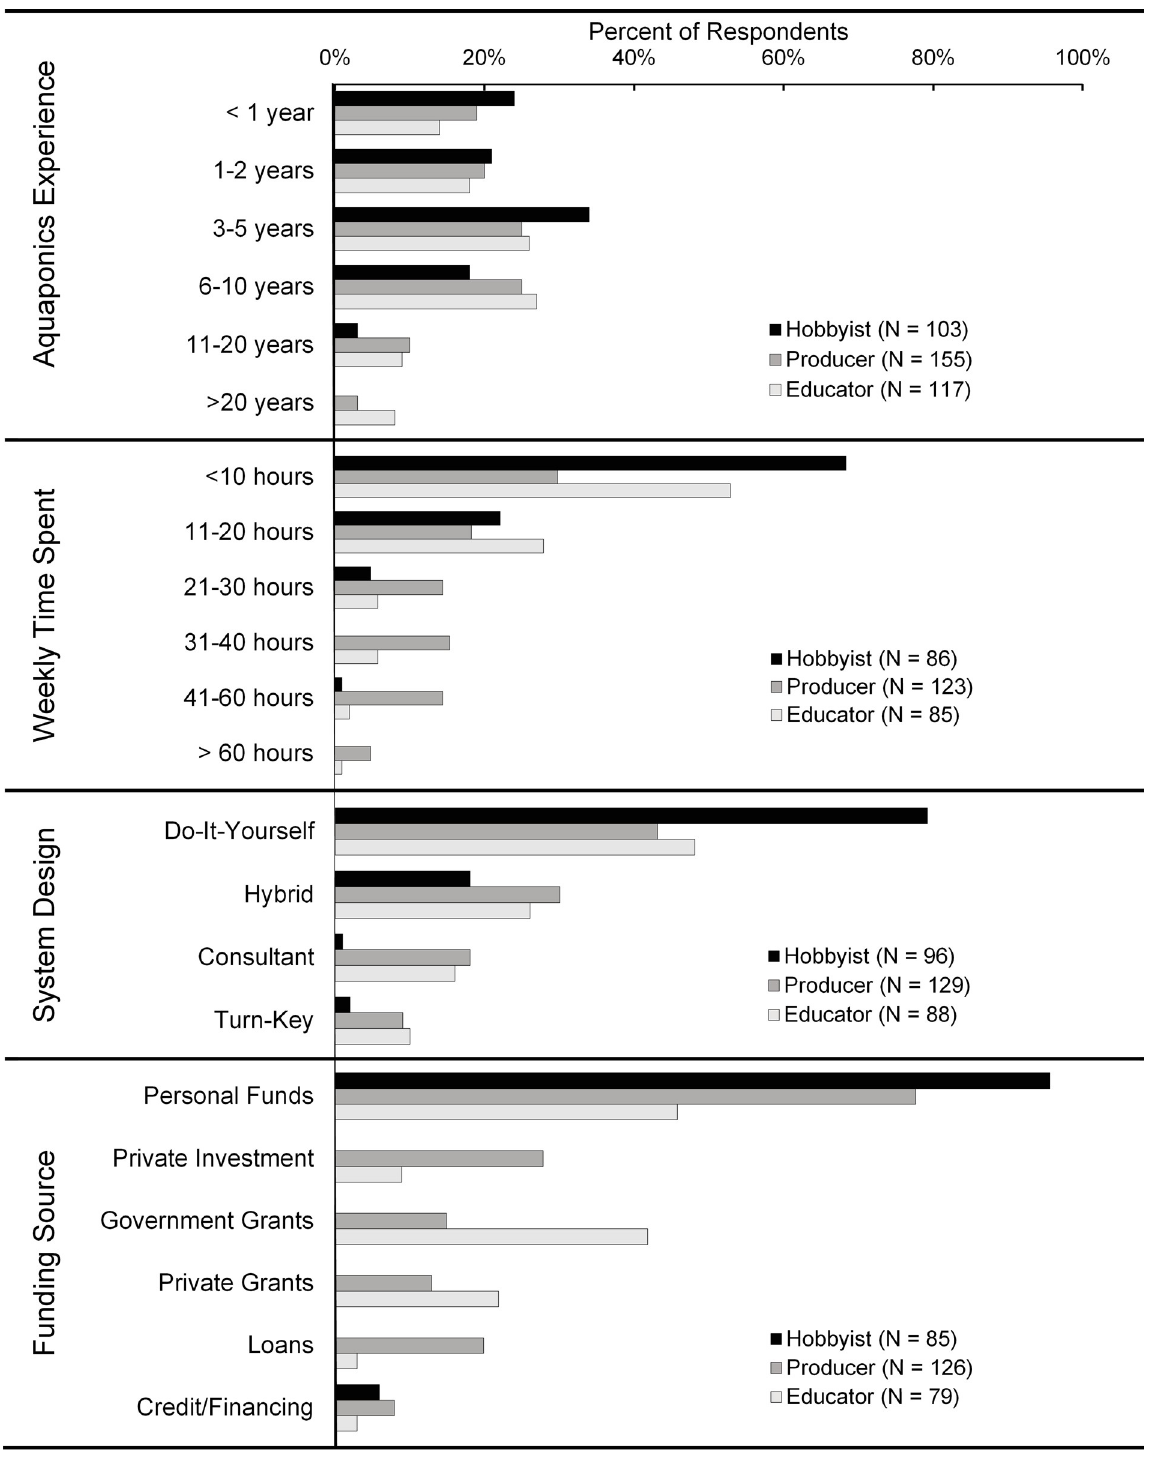
Fig 2. Survey respondent years of experience, weekly labor, system design, and funding sources.